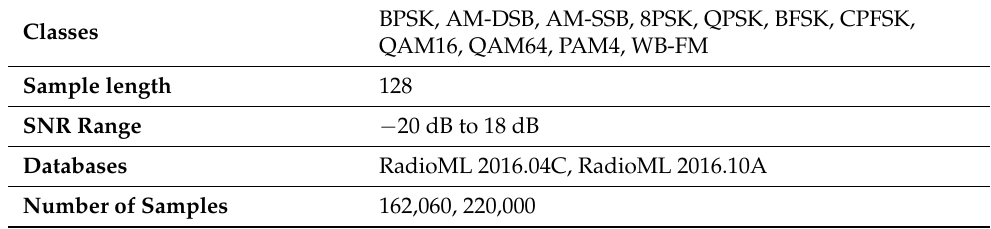
Table 1. Database